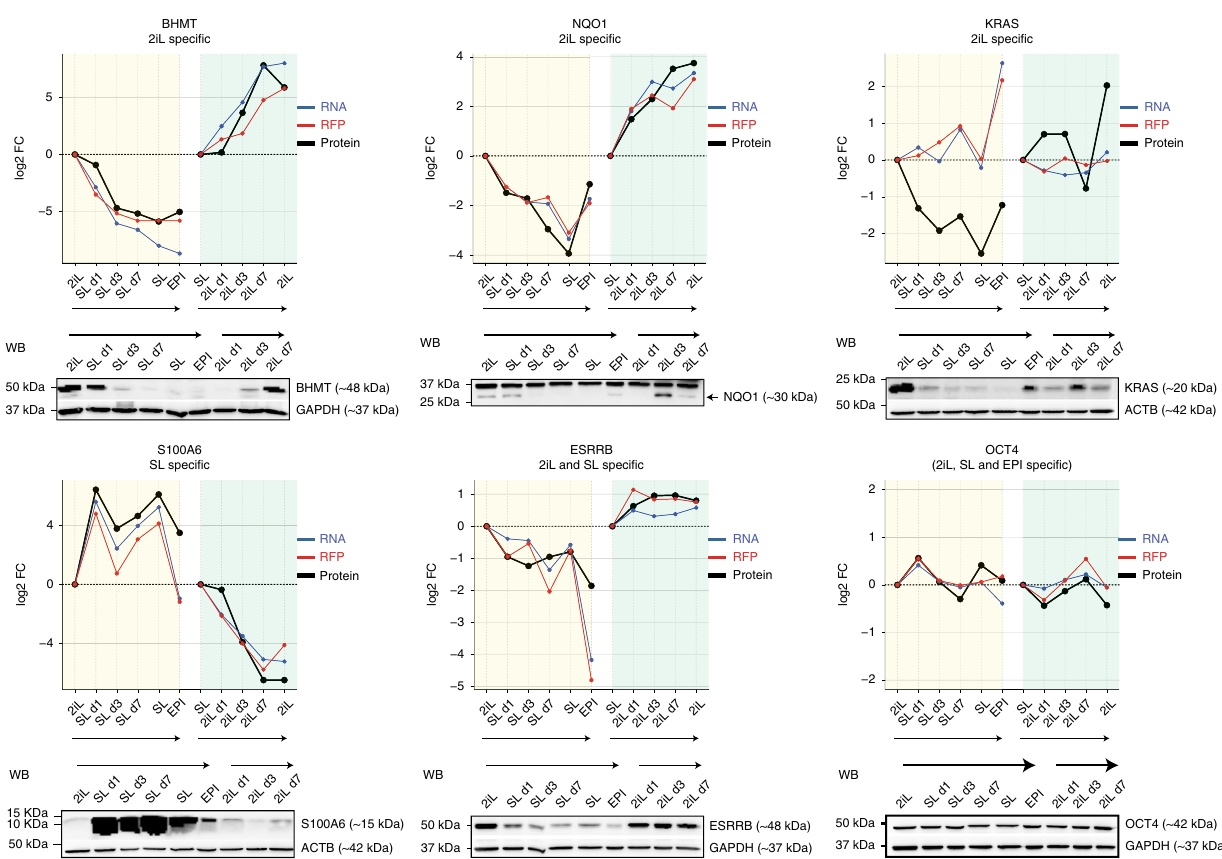
Fig. 4 Western blot validation of proteome data. Graphs showing the RNA, RFP, and protein expression levels of selected candidate genes based on RNA- seq, RFP-seq, and LC-MS proteomic analysis. Western blot analysis con fi rms the proteome data for the selected proteins in 2iL, SL, and EPI states and during 2iL – Sl transition. Candidate proteins included 2iL-speci fi c proteins, BHMT, NQO1, and KRAS; SL-speci fi c protein, S100A6; SL and 2iL-speci fi c protein, ESRRB and a general pluripotency protein (SL, 2iL, and EPI), OCT4. Note that Kras is regulated at the post-translational